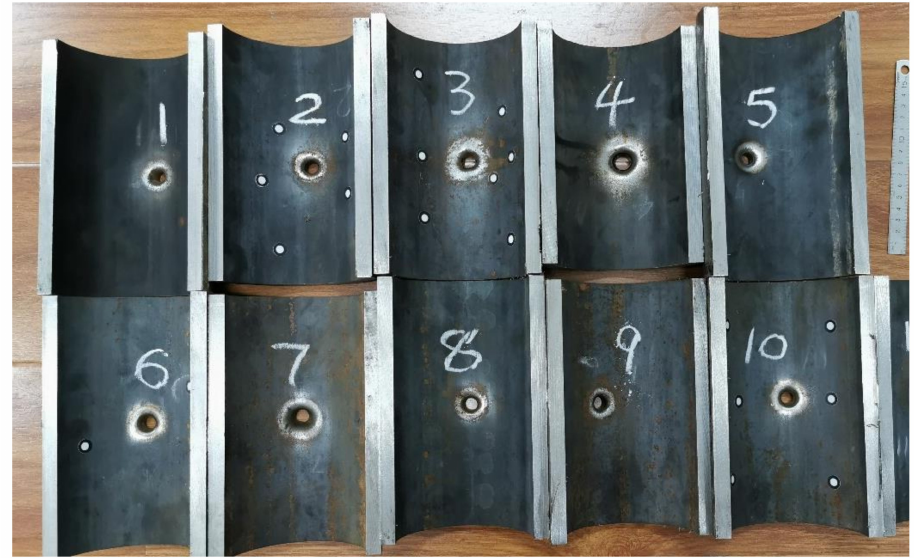
Figure 5. Internal perforation shapes in tests 1–10 after erosion.